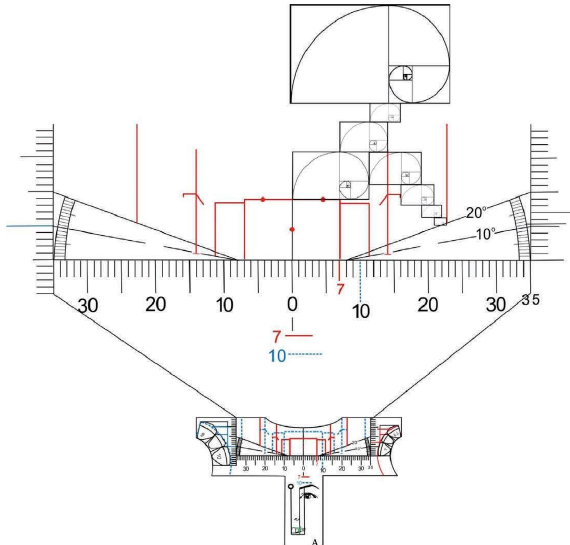
Figure 5: Anterosuperior presentation of the golden proportion concepts checked by the conventional golden proportion graphic scheme lines.